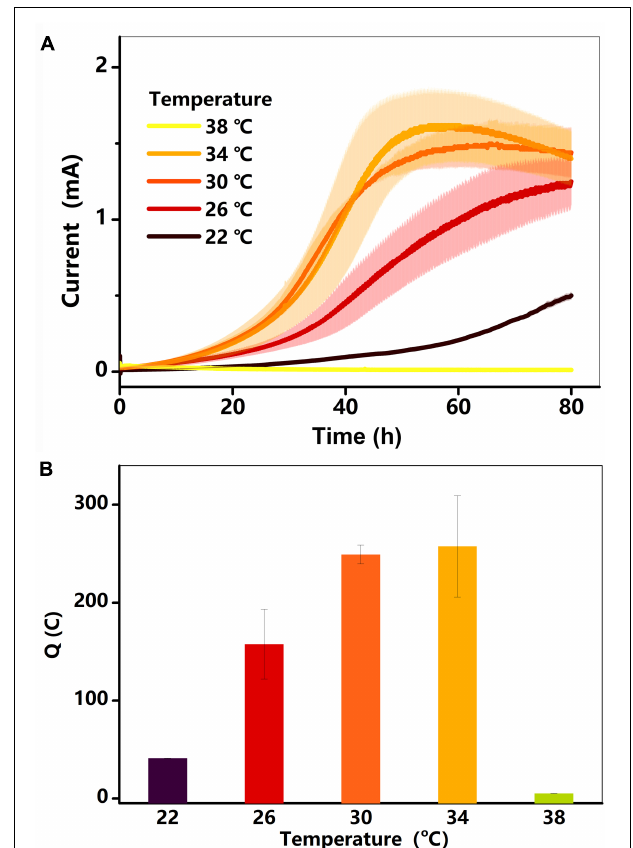
FIGURE 1 | (A) Current ( I , mA) in BESs against time at different temperatures (22–38 ◦ C); (B) total charge as a function of temperature. Testing conditions: 50 µ M AQS, 50 mM lactate, 200 mM phosphate as pH buffer (pH = 7.0), OD 600 = 1.0, and external potential of 421 mV vs.